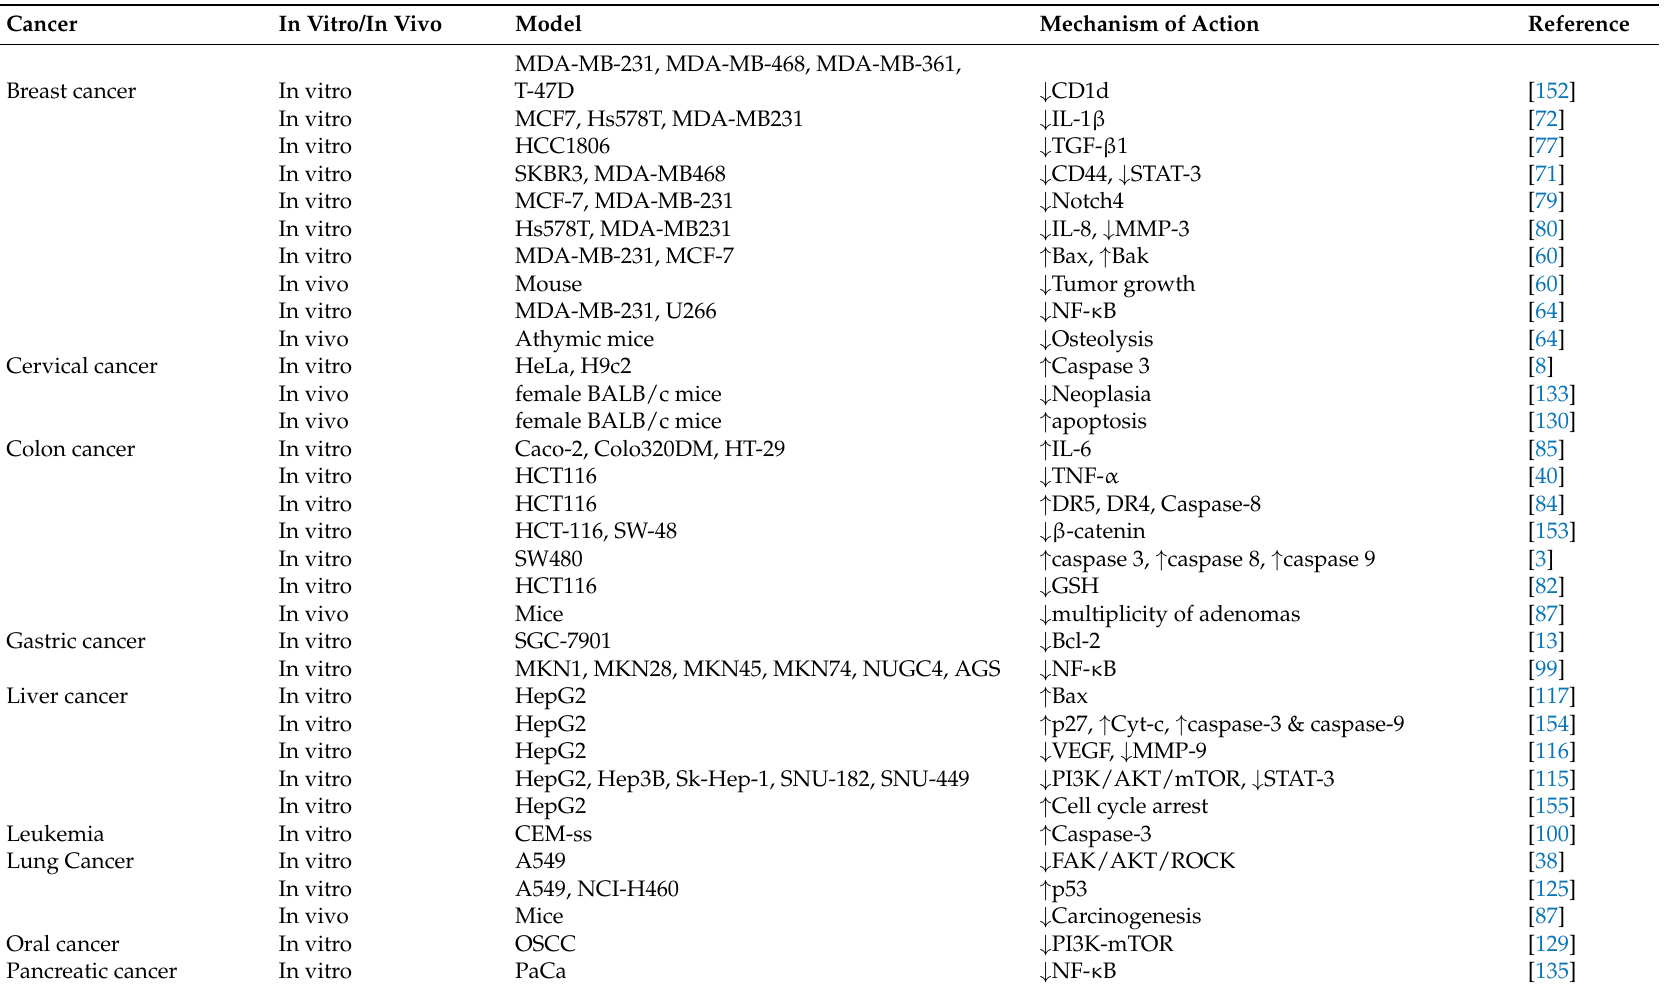
Table 1. Possible role of zerumbone against various